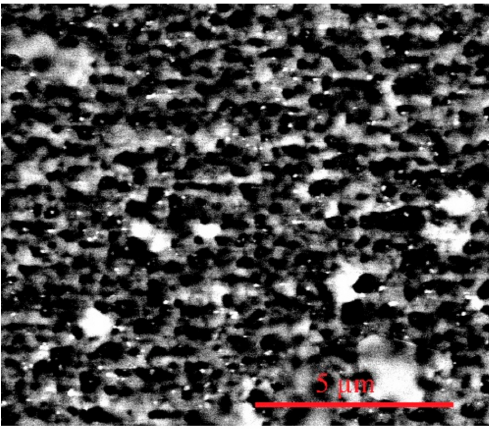
Figure 7. The SEM micrographs for the 10 Mg sample after the impedance measurements (gold electrodes > 700